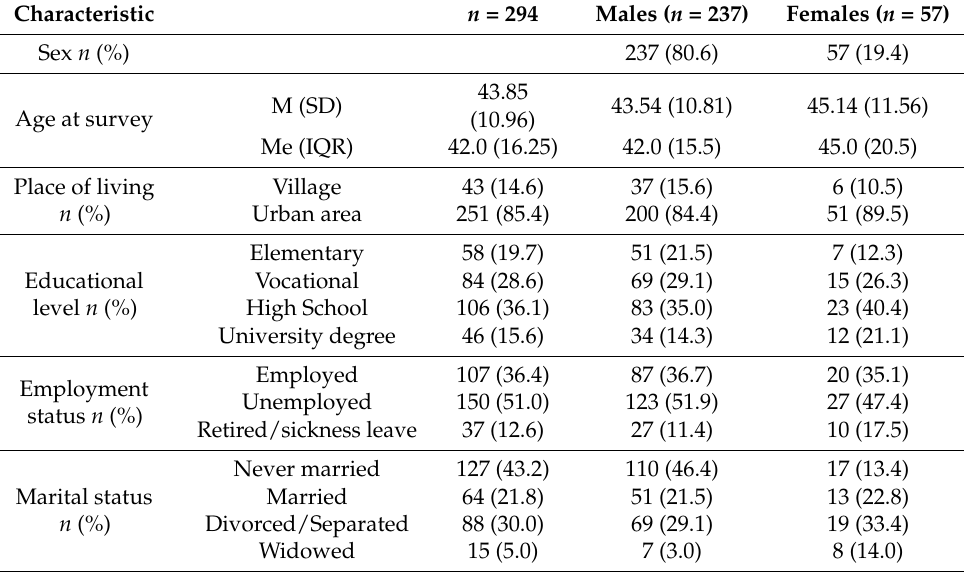
Table 1. Socio-demographics and descriptive characteristics of study patients with alcohol depen- dence ( n =